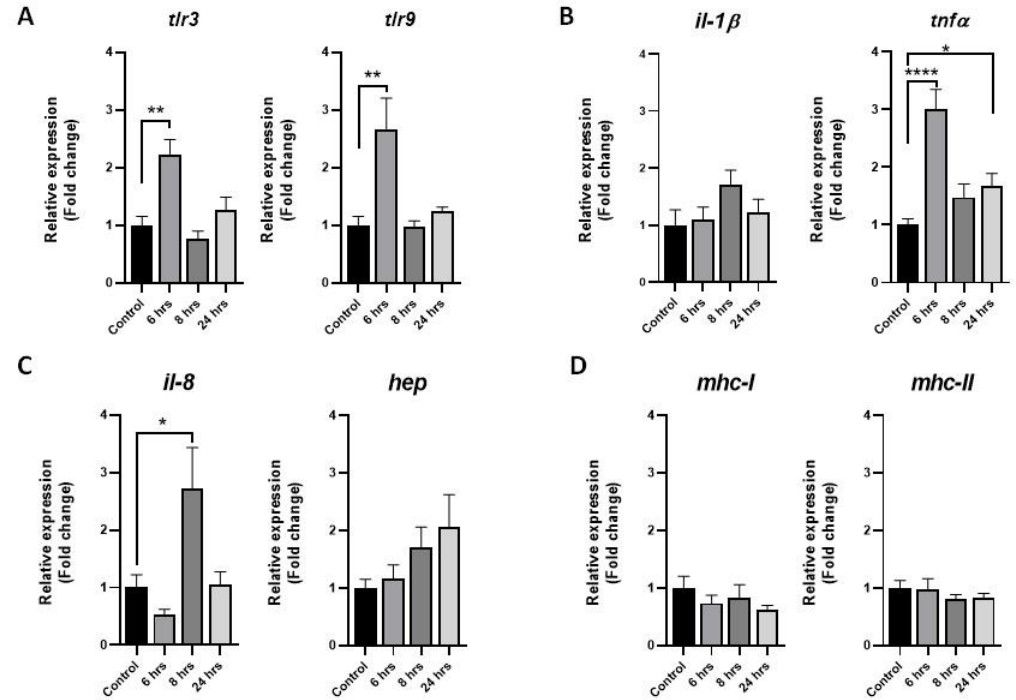
Figure 1. Expression of immune molecular markers in rainbow-trout muscle cells after Piscirickettsia salmonis challenge. Primary cultures of fish skeletal muscle were challenge with P. salmonis (MOI 10) for 6, 8, and 24 h. As control group, cells were treated with a vehicle (DMEM + 10% FBS). ( A ) Toll-like receptors 3 and 9. ( B ) Proinflammatory cytokines il-1 β and tnf α . ( C ) il-8 and the antimicrobial peptide hepcidin . ( D ) Major complex of histocompatibility I and II ( mhc-I and mhc-II ). qPCR analyses were normalized with the ef-1 α and β -actin genes, and the results are presented as means ± SEMs of triplicates from three independent experiments, using fold change compared to the control values (n = 3). The difference in the transcript levels is denoted by asterisks (*) considering a p -value < 0.05 (*), p -value < 0,01 (**) and p -value < 0.001 (****)